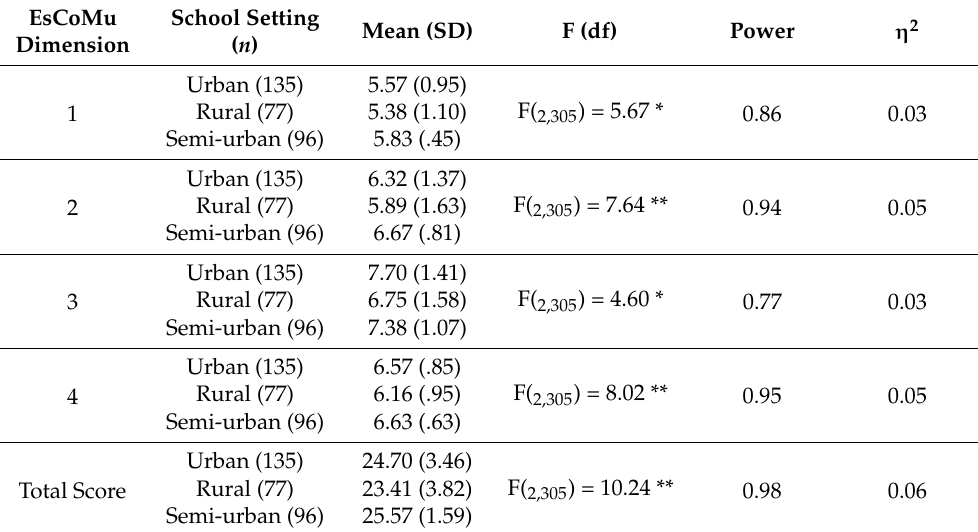
Table 9. MANOVA results for school setting with EsCoMu dimensions